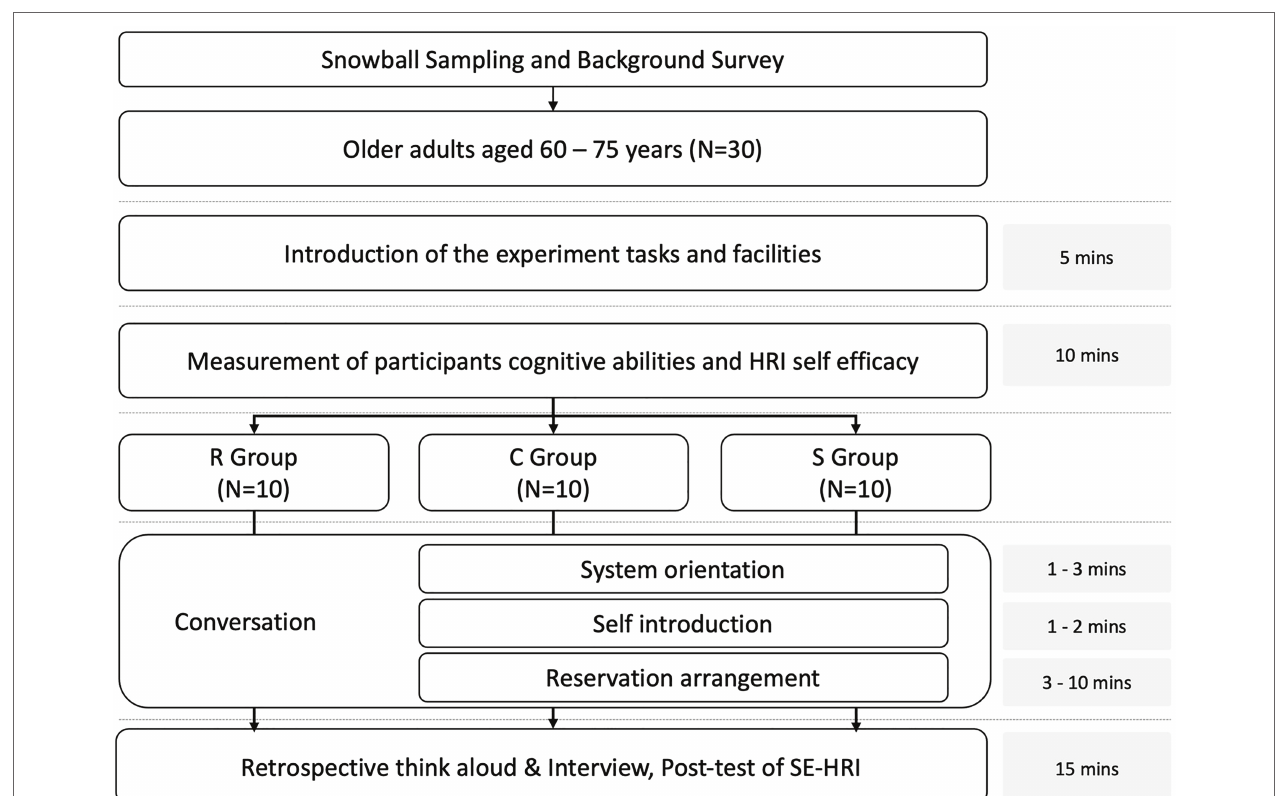
FIGURE 1 | The procedure of the experiment.